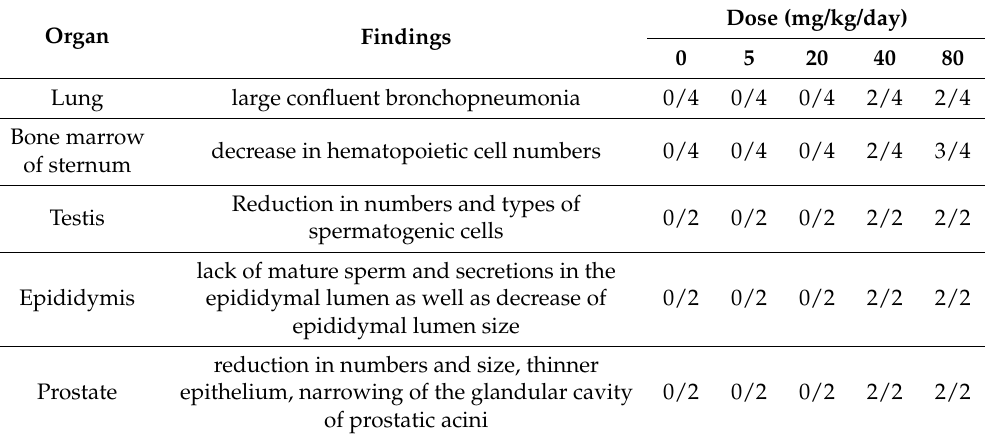
Table 5. Selected histopathological findings in dogs after 28 days of treatment with HZ1006.